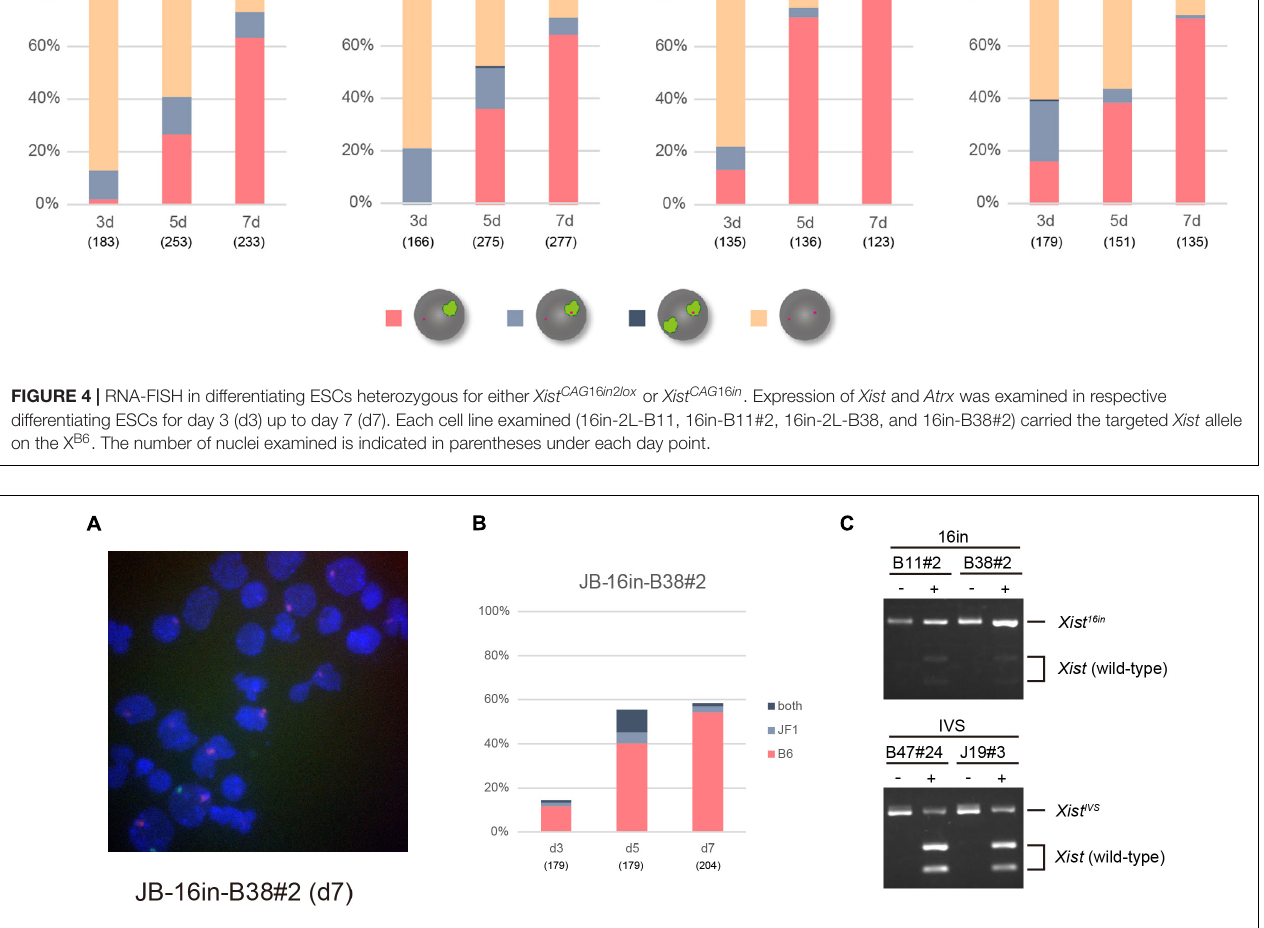
FIGURE 5 | Xist 16 in RNA induces stable XCI. (A) Representative images of allele-specific RNA-FISH for Xist in 16in-B38#2 differentiated for 7 days. Xist RNA originated from the X B6 and X JF1 is shown in red and green, respectively. (B) Proportion of nuclei harboring the Xist cloud of the X B6 or X JF1 in origin or both in differentiating 16in-B38#2 ESCs for d3 up to d7. (C) Expression of Xist 16 in and Xist IVS RNA in differentiating ESCs heterozygous for the Xist 16 in and Xist CAGIVS allele, respectively. The unique Xho I site present in the amplified fragment derived from wild-type Xist RNA was destroyed by the presence of the 16-base insertion in the amplified fragment derived from Xist 16 in and Xist IVS RNA. The presence of an undigested band by Xho I indicates the expression of Xist 16 in and Xist IVS RNA. (–) and (+) indicate undigested and digested,